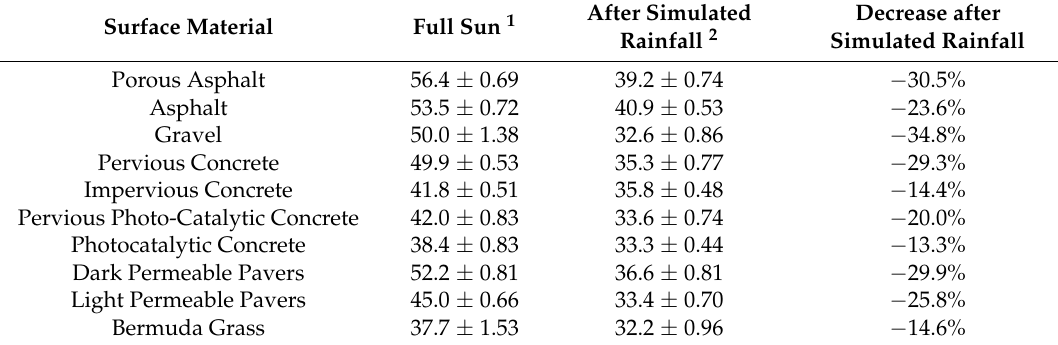
Table 2. Average steady-state surface temperatures of selected materials (from thermal imaging camera)